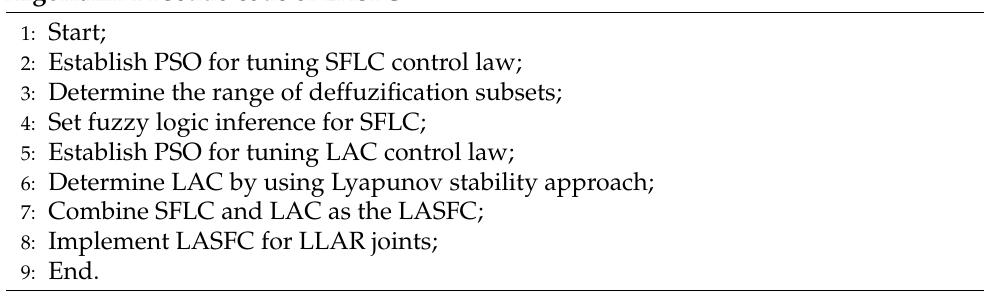
Algorithm 1 Pseudo code of